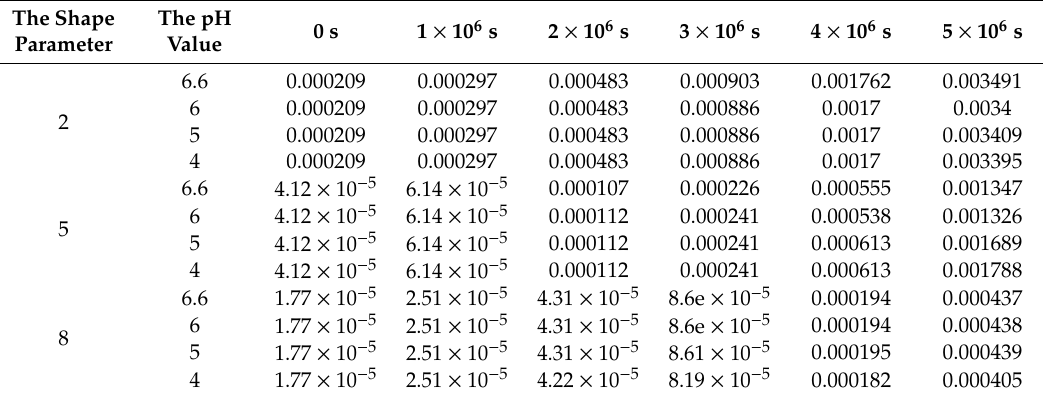
Table 2. The porosity variance at di ff erent pH values.